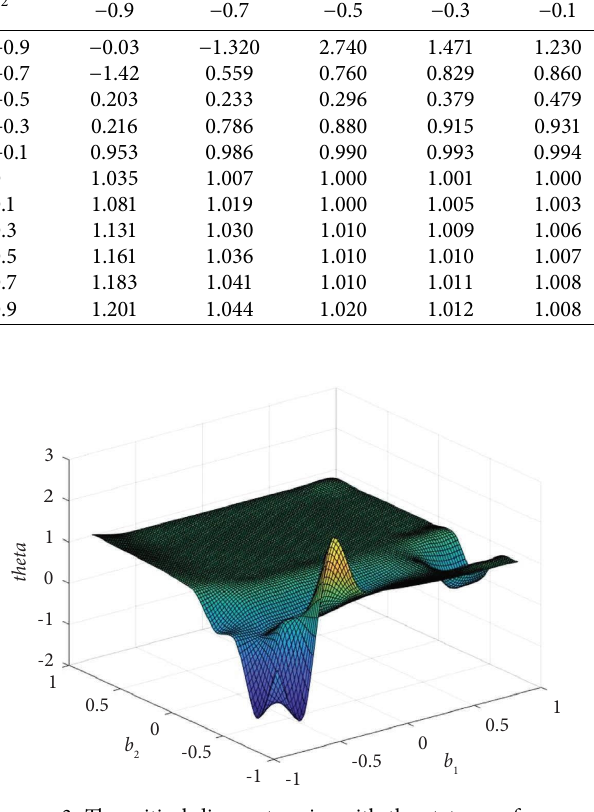
Figure 3: Te critical discount varies with the status preference.